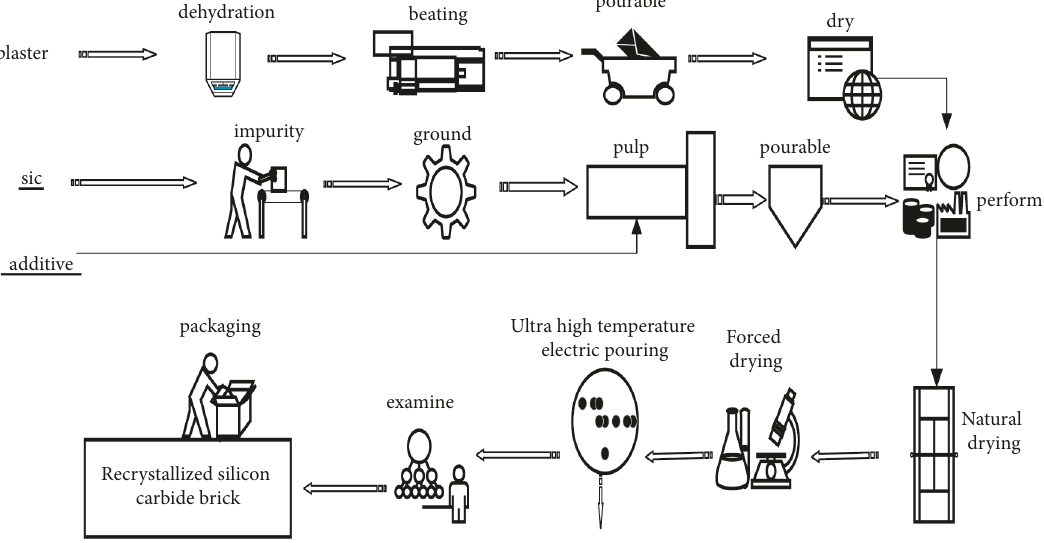
Figure 1: Preparation flowchart of silicon carbide.